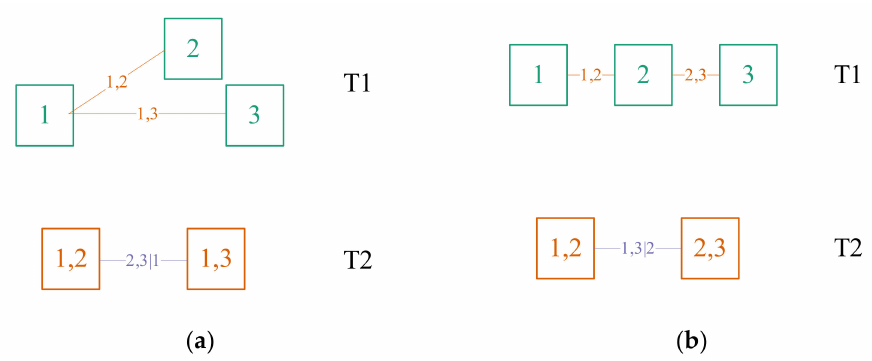
Figure 5. The vine structures for the given order of 3 variables with 2 trees and 3 edges in the canonical vine copula ( a ) and the D-vine copula ( b